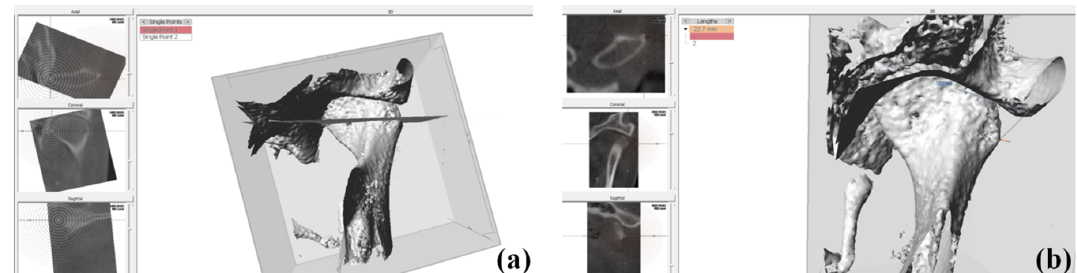
Figure 5. Linear measurements of condyle on Checkpoint: ( a ) single points placed on the medial and